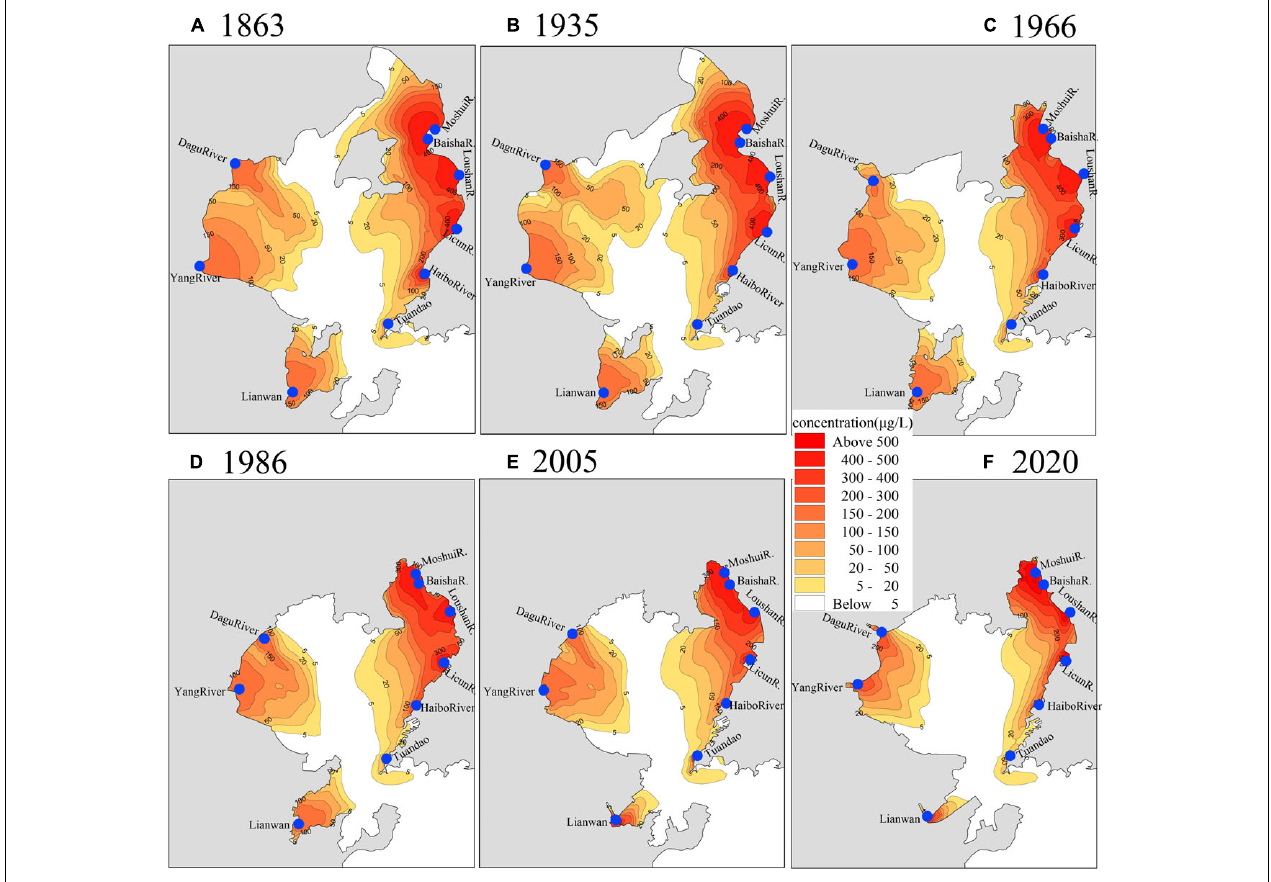
FIGURE 11 | Spring-neap tidal averaged dissolved inorganic nitrogen concentration in (A) 1863 (B) 1935 (C) 1966 (D) 1986 (E) 2005 (F) 2020.